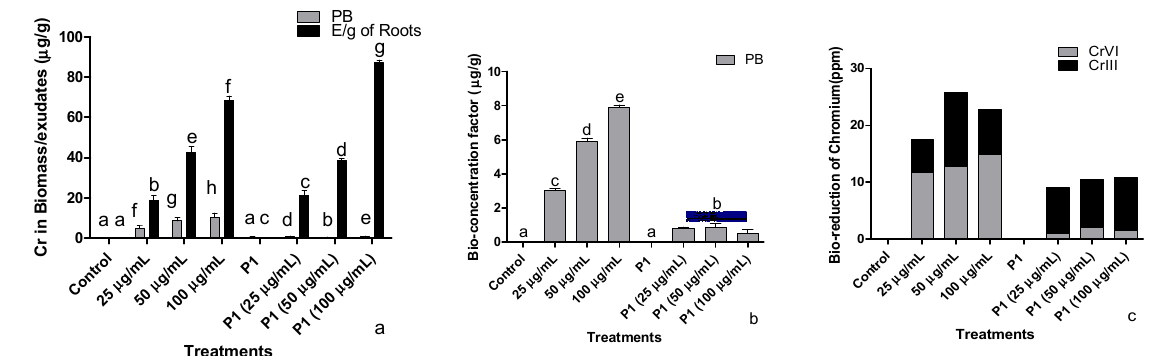
Figure 7. Influence of rhizobacterium P1 on ( a ) absorptions/accumulation, ( b ) bioconcentration, and ( c ) bio-reduction of Cr +6 in sunflower seedlings. The seedlings were grown hydroponically in Hoagland media (half strength) containing different concentrations of hexavalent chromium for 16 days in a plant growth chamber. Data are a mean of 36 replicates with SE and the alphabets representing significance (Duncan; p < 0.05).